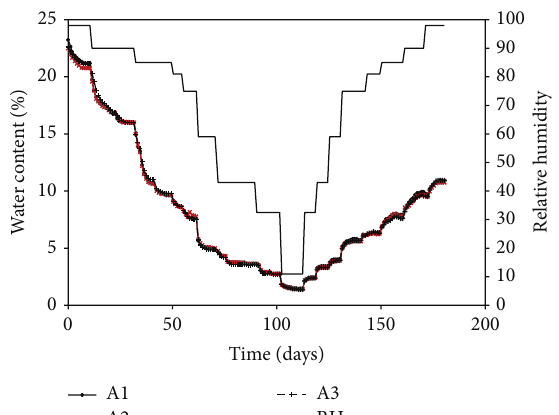
Figure 1: Hydration and dehydration path and the corresponding water content evolution of the samples A1, A2, and A3.